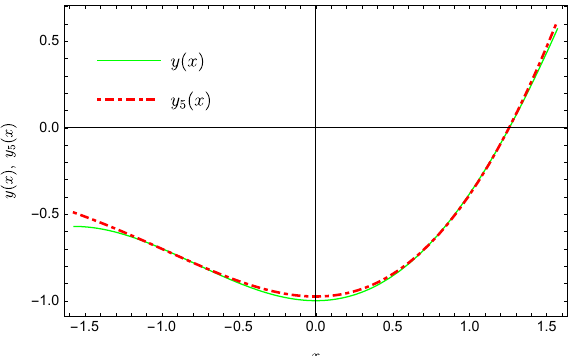
Figure 1. Exact solution and the approximate solution y 5 ( x ) .